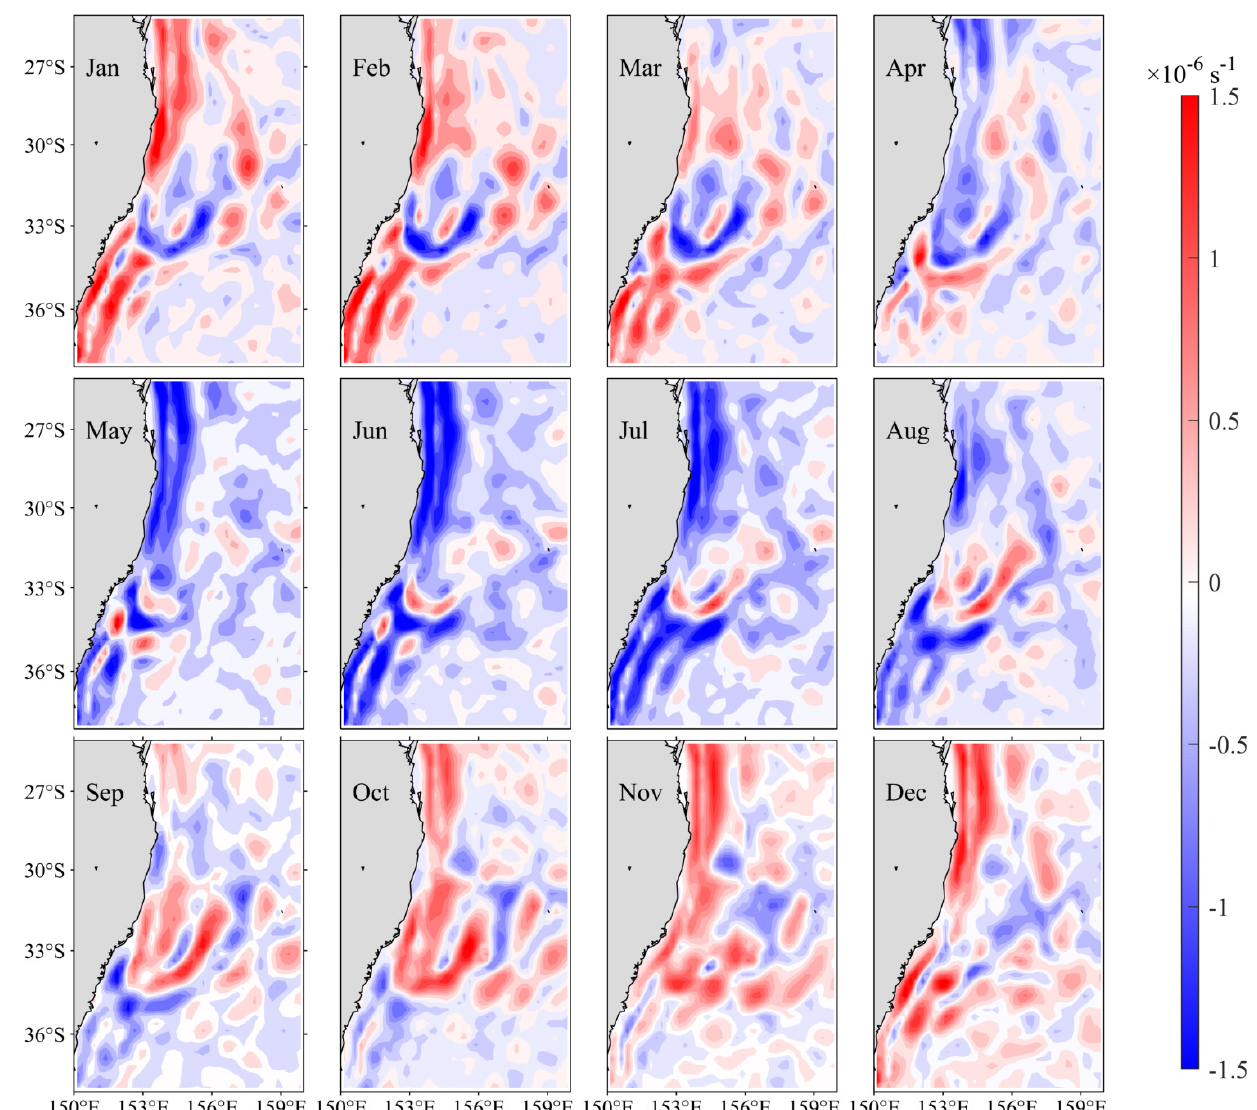
Figure 11. Monthly mean climatological lateral rate of strain (LRS) anomalies distributions averaged in the upper 500 m layer, which have subtracted the annual mean value. Here velocities are based on the 180-day low-pass filtered ECCO2 outputs.